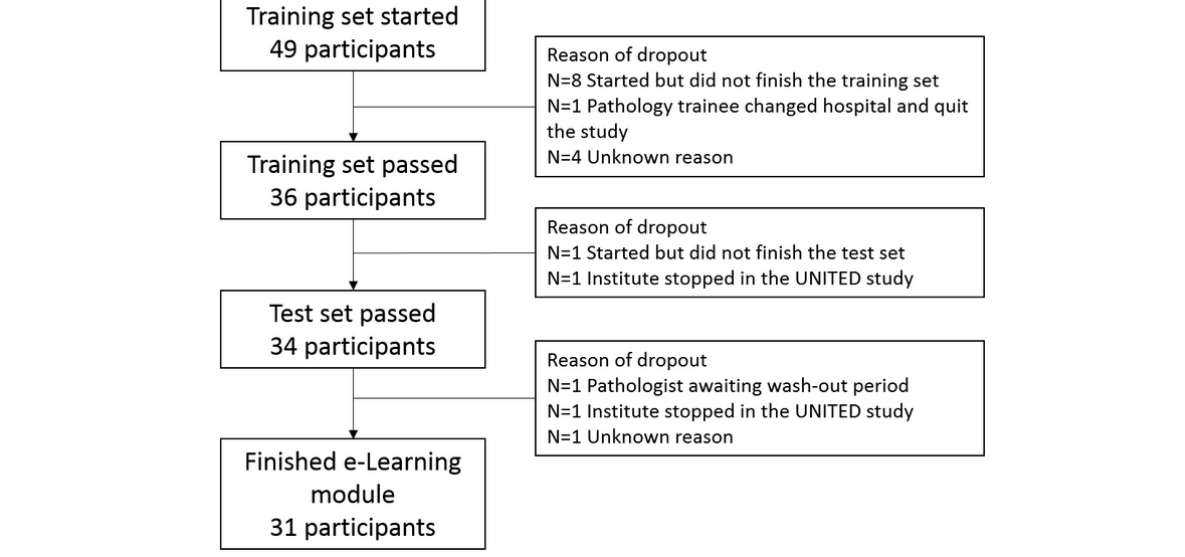
JMIR Form Res 2021 | vol. 5 | iss. 3 | e19408 | p. 3https://formative.jmir.org/2021/3/e19408 (page number not for citation